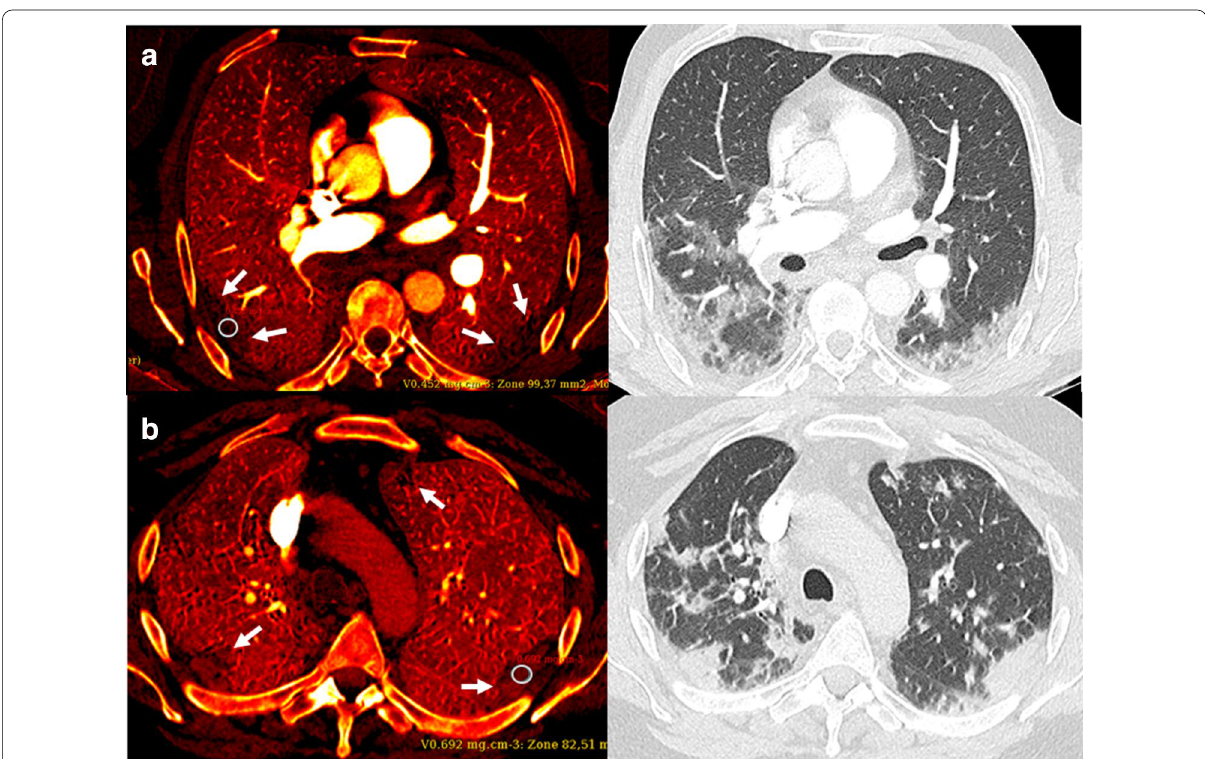
The main lesion exhibiting a perfusion defect in PD GGO: ground glass opacity; CS: consolidation; OP: organizing pneumonia’s suggestive features; CP: crazy-paving; TIB: tree-in-bud; PD defect; PD-: absence of perfusion